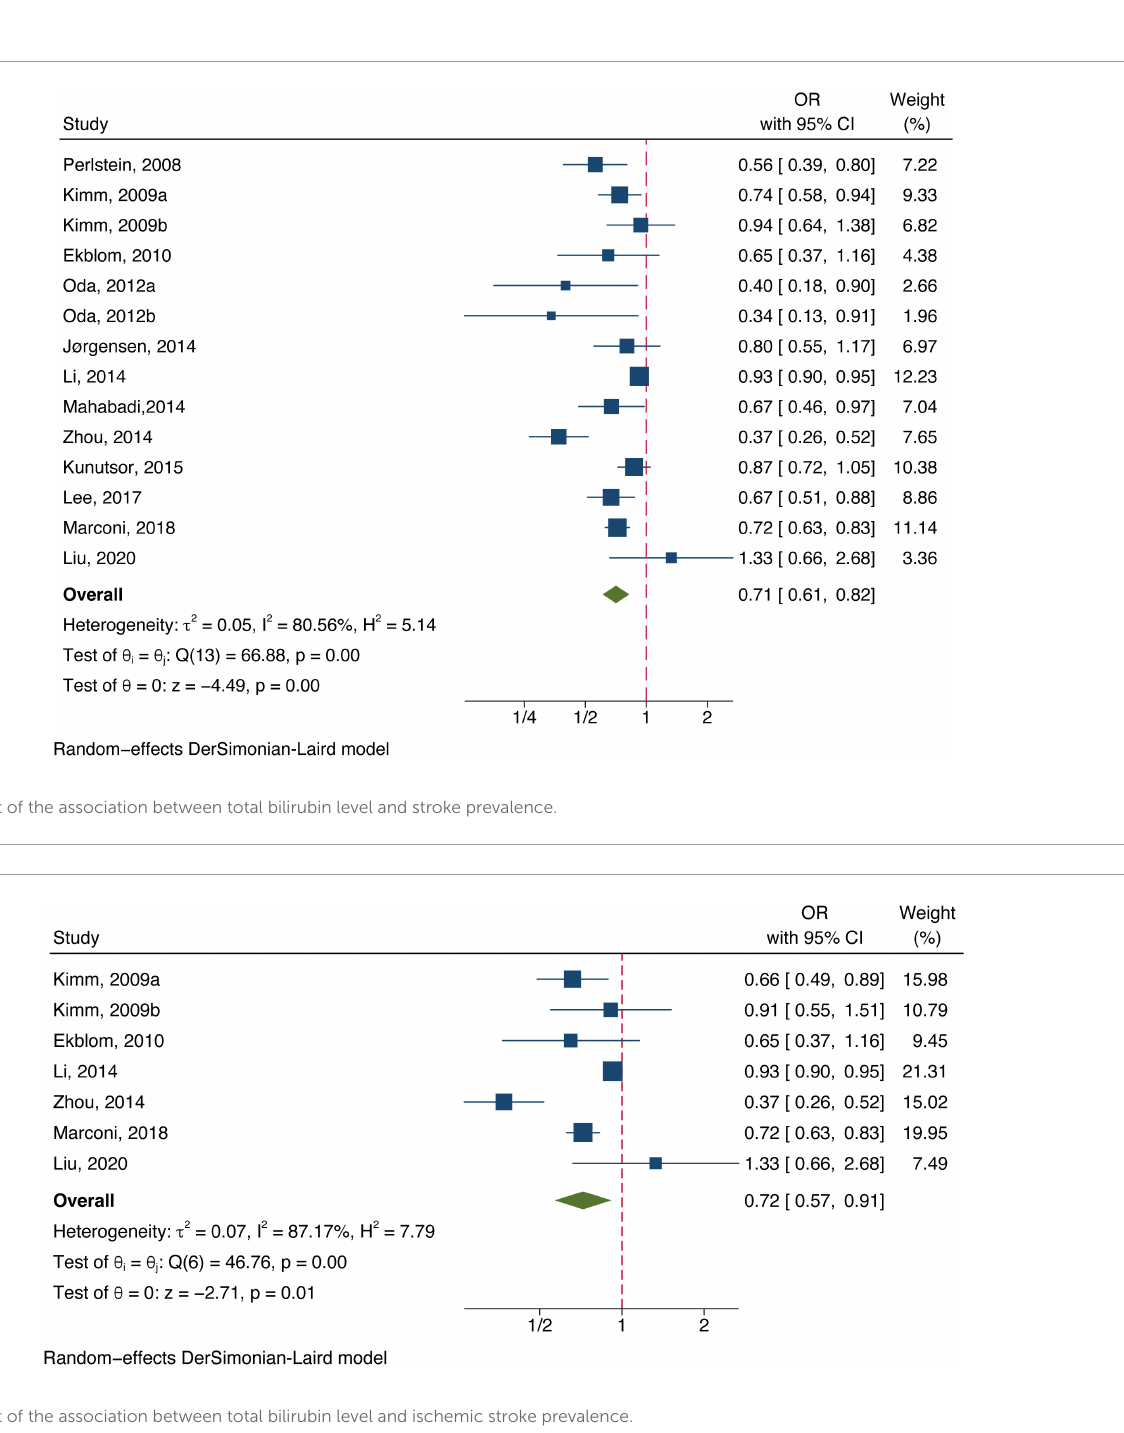
lower total bilirubin level (mean difference = − 1.33 µ mol/L, 95% CI: − 2.12 to − 0.53, P < 0.01, Supplementary Figure 3